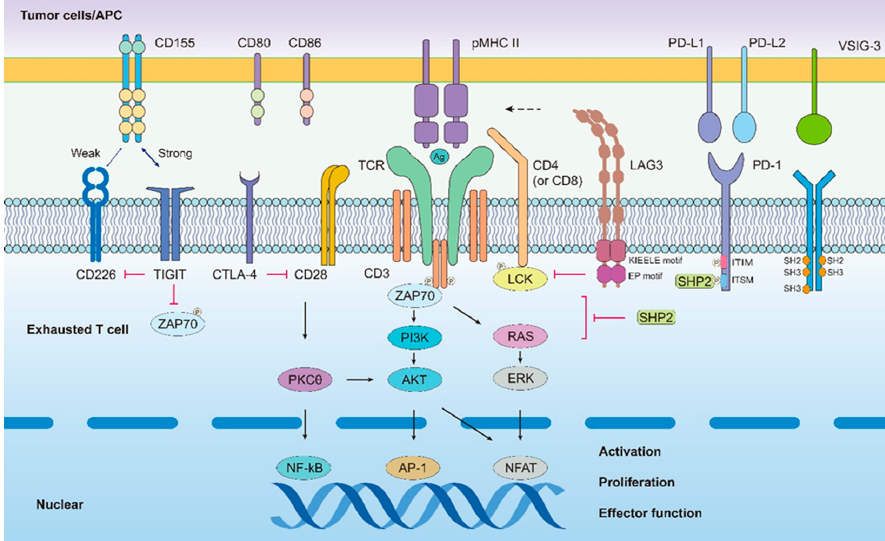
Figure A2. Interactions between co-stimulatory molecules CD80, CD86, CD28 and CD226 are crucial for appropriate T cell activation. Immune checkpoint inhibitors, including PD-1, CTLA-4, LAG3, TIGIT and VISTA 3 suppress T-cell signaling and induce T-cell exhaustion by interacting with related ligands expressed on 4 APCs/tumor cells. Many inhibitory receptors on exhausted T cells have intracellular immunoreceptor tyro- 5 sine-based inhibitory motifs (ITIMs) and/or immunoreceptor tyrosine-based switching motifs (ITSMs). 6 However, some receptors have specific motifs, such as KIEELE for lymphocyte activation gene 3 protein 7 (LAG3). Inhibitory receptors induce T cell exhaustion through mechanisms including competition for ligands with positive regulator molecules (TIGIT competes with CD226 to limit T cell function), interference 9 with TCR activation signaling (LAG3 drives co-receptor-LCK dissociation, which hampers the signaling 10 cascade and leads to T cell exhaustion), and upregulation of genes associated with T cell exhaustion (PD-1 11 with PD-L1 during the T cell exhaustion period recruits the PD-1/SHP2 tyrosine phosphatase complex to 12 reduce the activity of key nuclear transcription factors that are important for T cell proliferation and differentiation, such as NF- κβ , AP-1, and NFAT).